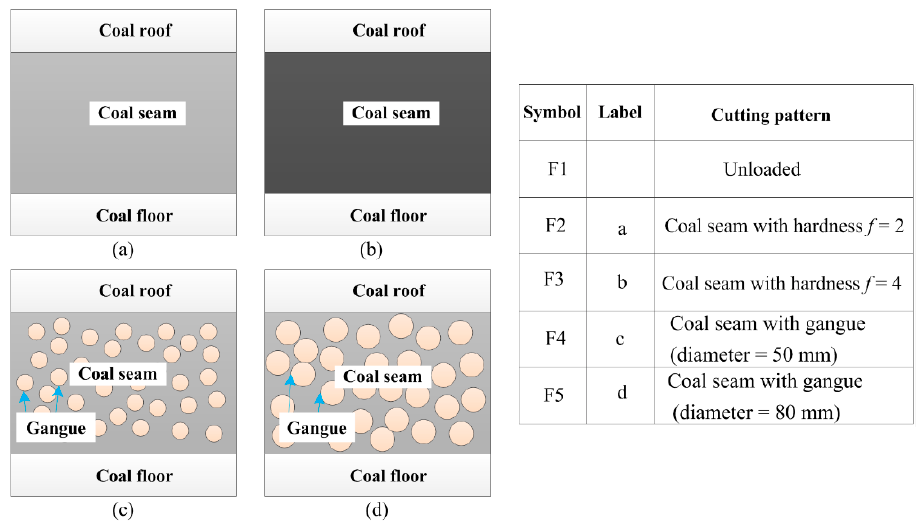
Figure 5. Different geological conditions of coal seam.